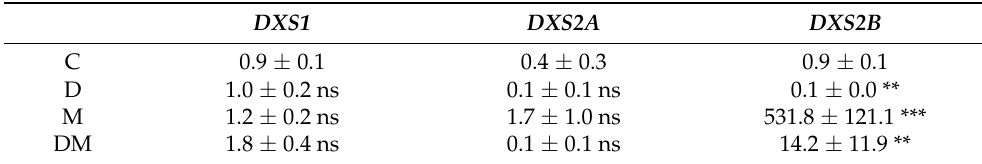
Table 1. Effect of application of drought (D) and MeJA (M), separately and combined (D + M), on expression of DXS1 , DXS2A, and DXS2B at second sampling time. Data are normalized to the abundance of ubiquitin . Results are given as mean ± SEM, and were evaluated by two-way ANOVA. ns, not significant; **, p < 0.01; ***, p < 0.001; C,